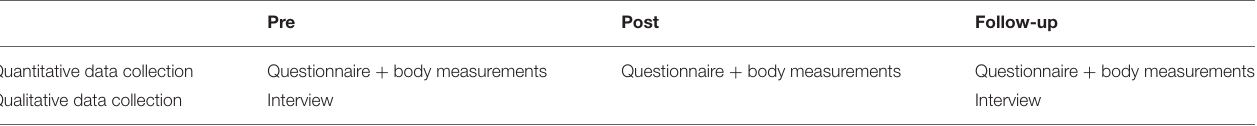
TABLE 1 | Study overview intervention timeline. Pre